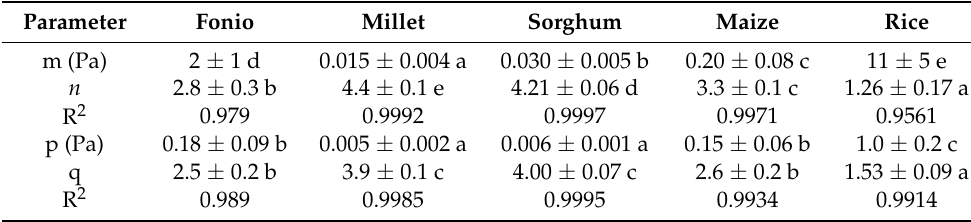
Table 4. Parameters obtained from fitting to the power-law model the experimental G 1 (cid:48) and G 1 (cid:48)(cid:48) data in function of the flour concentration in the gels (G 1 (cid:48) = m · C n ; G 1 (cid:48)(cid:48) = p · C q ). Parameter Fonio Millet Sorghum Maize Rice m (Pa) 2 ± 1 d 0.015 ± 0.004 a 0.030 ± 0.005 b 0.20 ± 0.08 c 11 ± 5 e n 2.8 ± 0.3 b 4.4 ± 0.1 e 4.21 ± 0.06 d 3.3 ± 0.1 c 1.26 ± 0.17 a R 2 0.979 0.9992 0.9997 0.9971 0.9561 p (Pa) 0.18 ± 0.09 b 0.005 ± 0.002 a 0.006 ± 0.001 a 0.15 ± 0.06 b 1.0 ± 0.2 c q 2.5 ± 0.2 b 3.9 ± 0.1 c 4.00 ± 0.07 c 2.6 ± 0.2 b 1.53 ± 0.09 a R 2 0.989 0.9985 0.9995 0.9934 0.9914 The coefficients m and p represent the values of the G 1 (cid:48) and G 1 (cid:48)(cid:48) moduli at a concentration of 1%; n and q exponents inform about the dependence degree of both moduli on flour concentration. Values with a letter in common in the same row are not significantly different ( p >